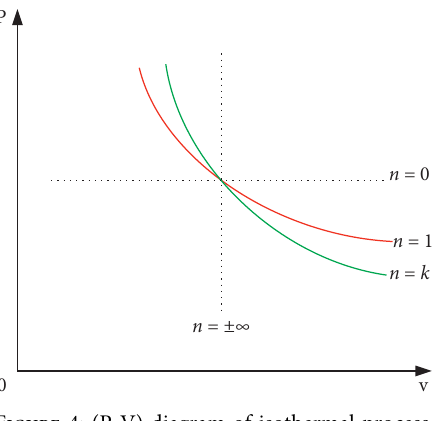
Figure 4: (P-V) diagram of isothermal